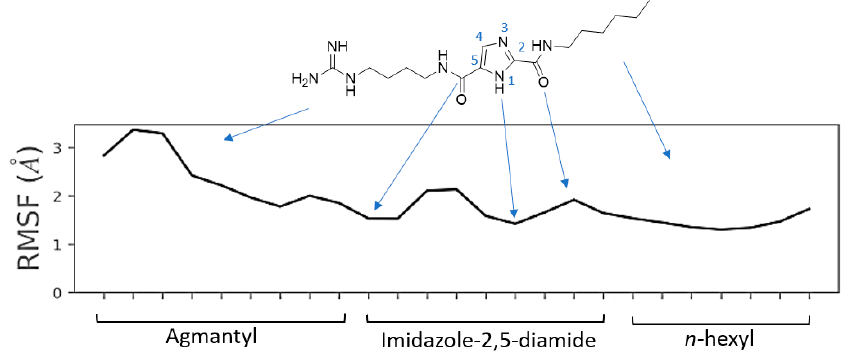
Figure 7. Root mean square fluctuations (RMSF) of MOC-24 heavy atoms. Note the highest conformational instability of the guanidine terminal and low motility of both the imidazole diamide core and the n-hexyl side chain.